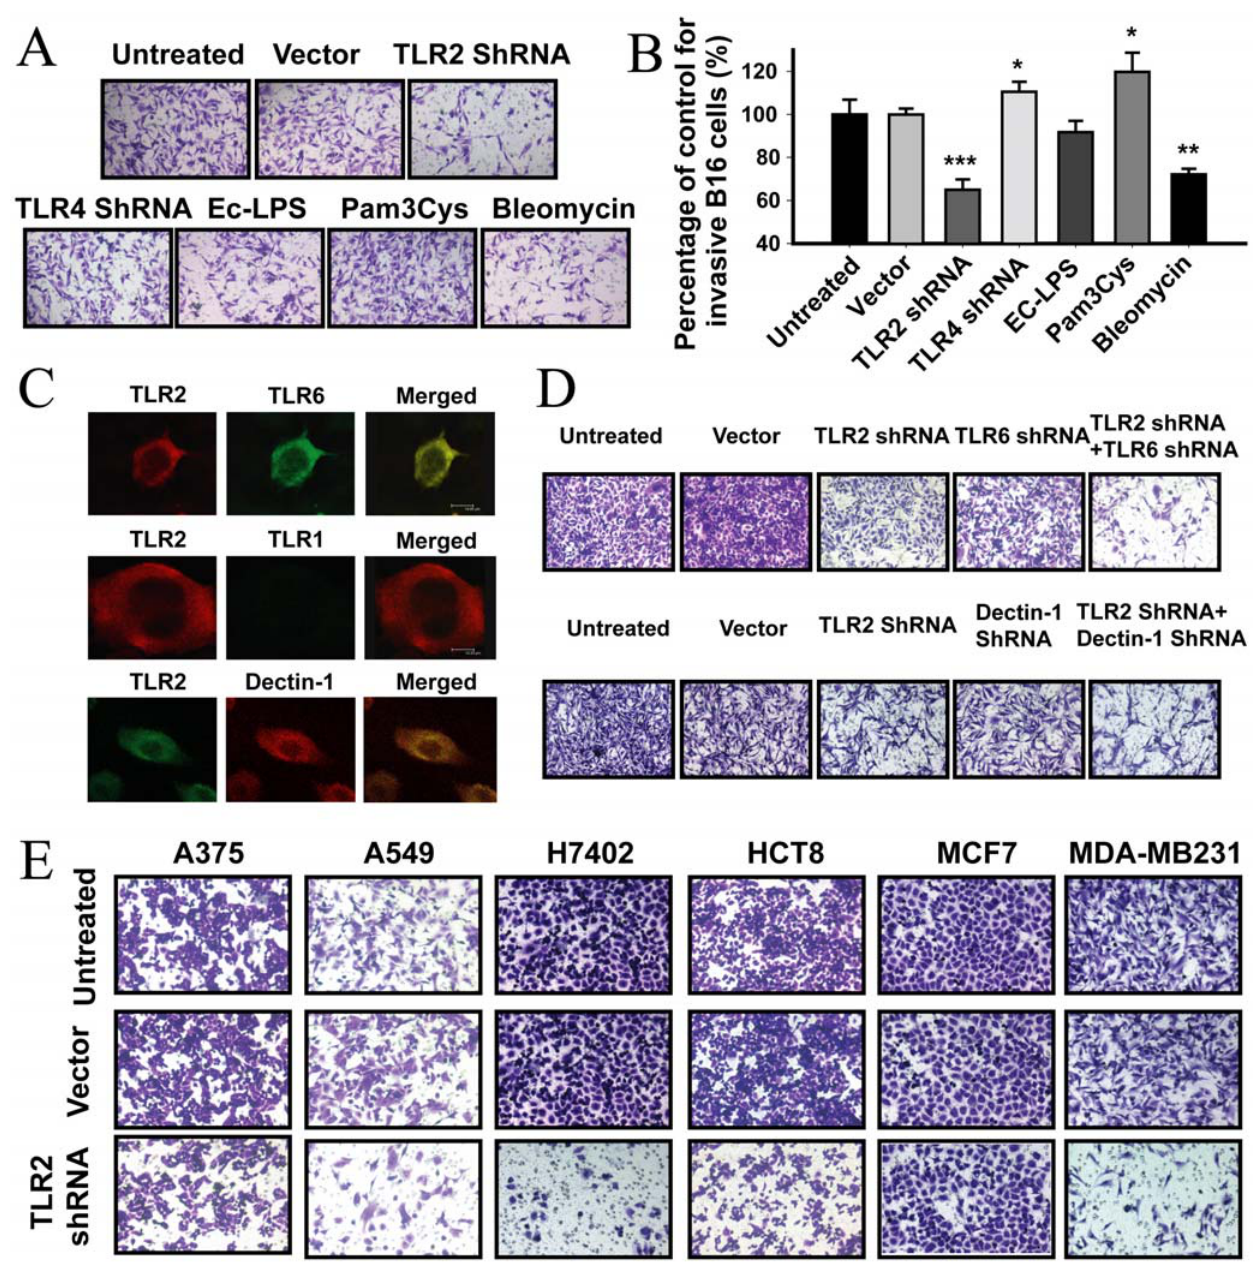
Figure 1. TLR2 was responsible for the invasion of tumor cells. (A–B) Knockdown of TLR2 attenuated the invasion of B16 cells. B16 cells were seeded in transwell plates (5000 cells per well) and treated with Ec-LPS (100 ng/mL), Pam3Cys (1 m g/mL), TLR2- or TLR4-shRNA or bleomycin (10 mU/ mL) for 48 h. (C) TLR2 co-localized with TLR6 or Dectin-1 on B16 cells. Data is a representative of three independent experiments. Original magnification is 500 6 . (D) Knockdown of TLR2/TLR6 or TLR2/Dectin-1 resulted in a synergized inhibition of B16 cell invasion. Data is representative of two independent experiments in duplicates. Original magnification is 200 6 . (E) TLR2 mediated the invasive activity of multiple human tumor cell lines. The data is a representative image of two independent experiments. Original magnification is 200 6